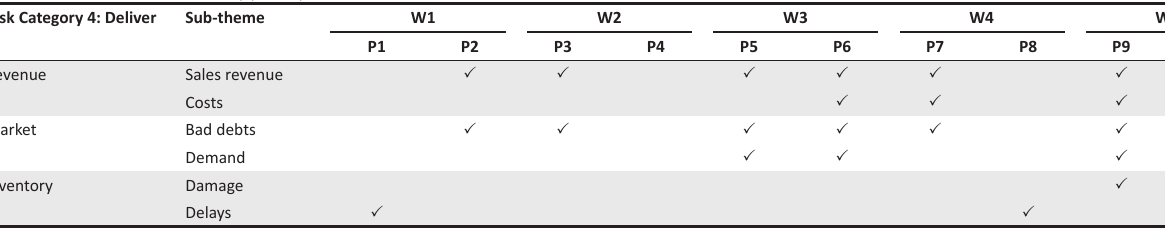
TABLE 5 : Deliver risks identified by participants. Risk Category 4: